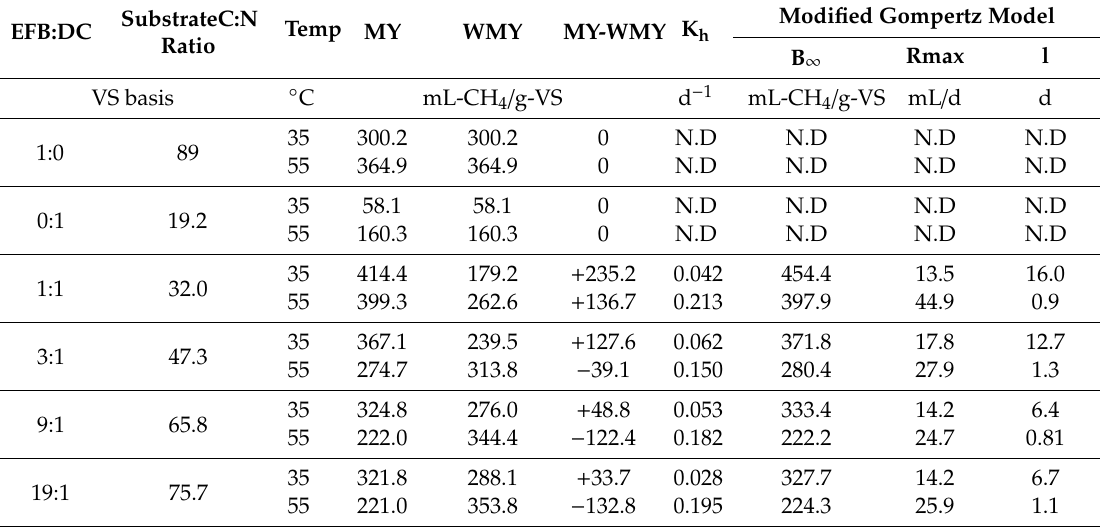
Table 2. Methane generated from solid stage anaerobic co-digestion of EFB and DC at S:I ratio